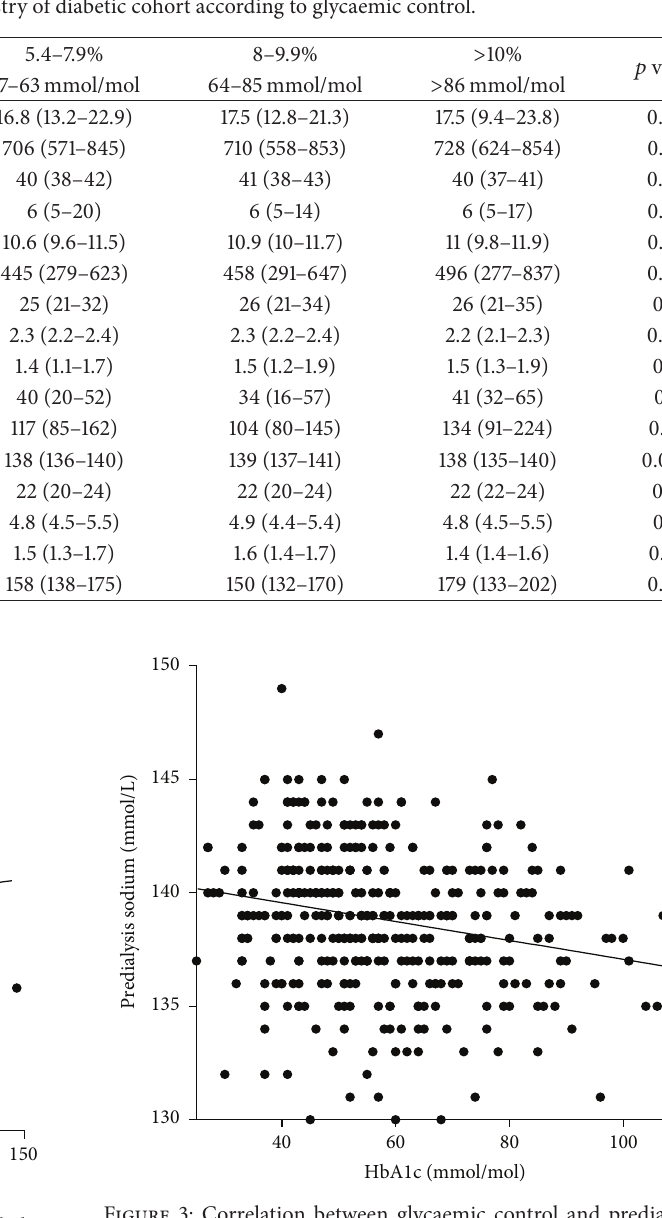
Figure 2: Correlation between glycaemic control and interdialytic weight gains.